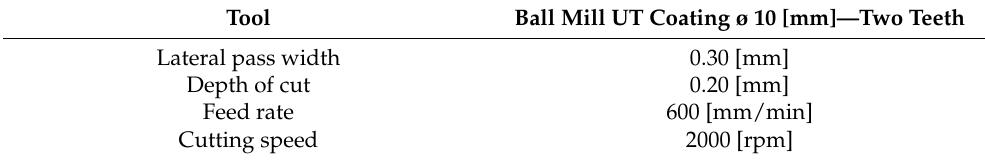
Figure 1. Stainless steel microstructural characterization.